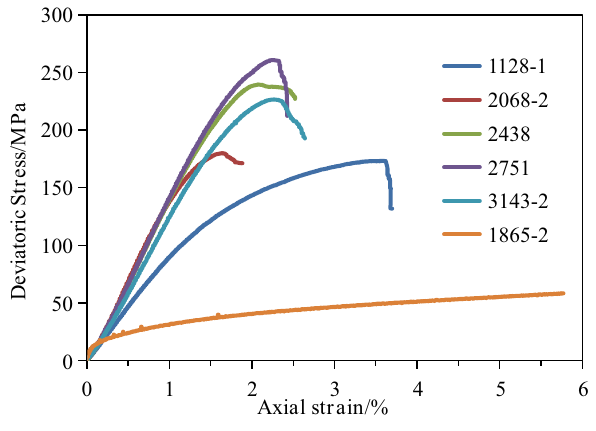
Fig. 3 Stress–strain curves of different samples under triaxial com- pression